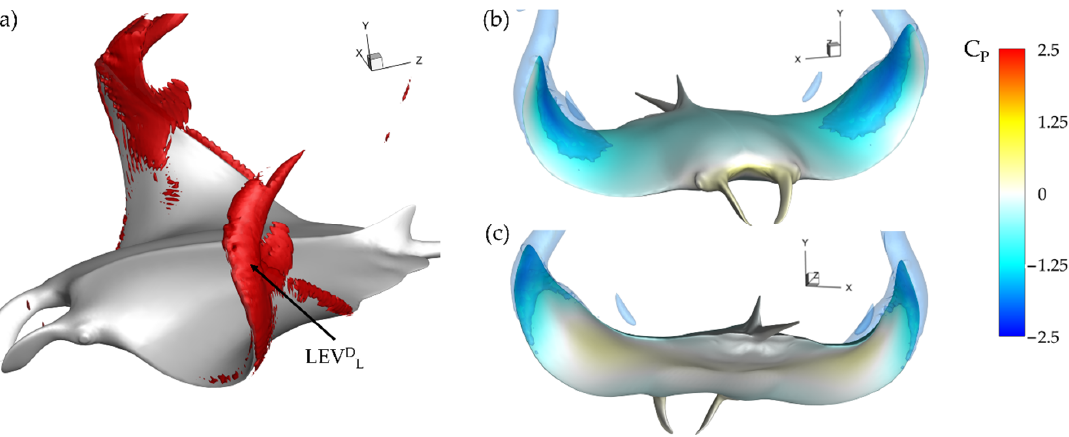
Figure 10. Baseline case (BR = 1.0 PR = 1.0) ( a ) Vorticity magnitude at half downstroke with ( b , c ) resulting surface pressure on top and bottom, respectively.